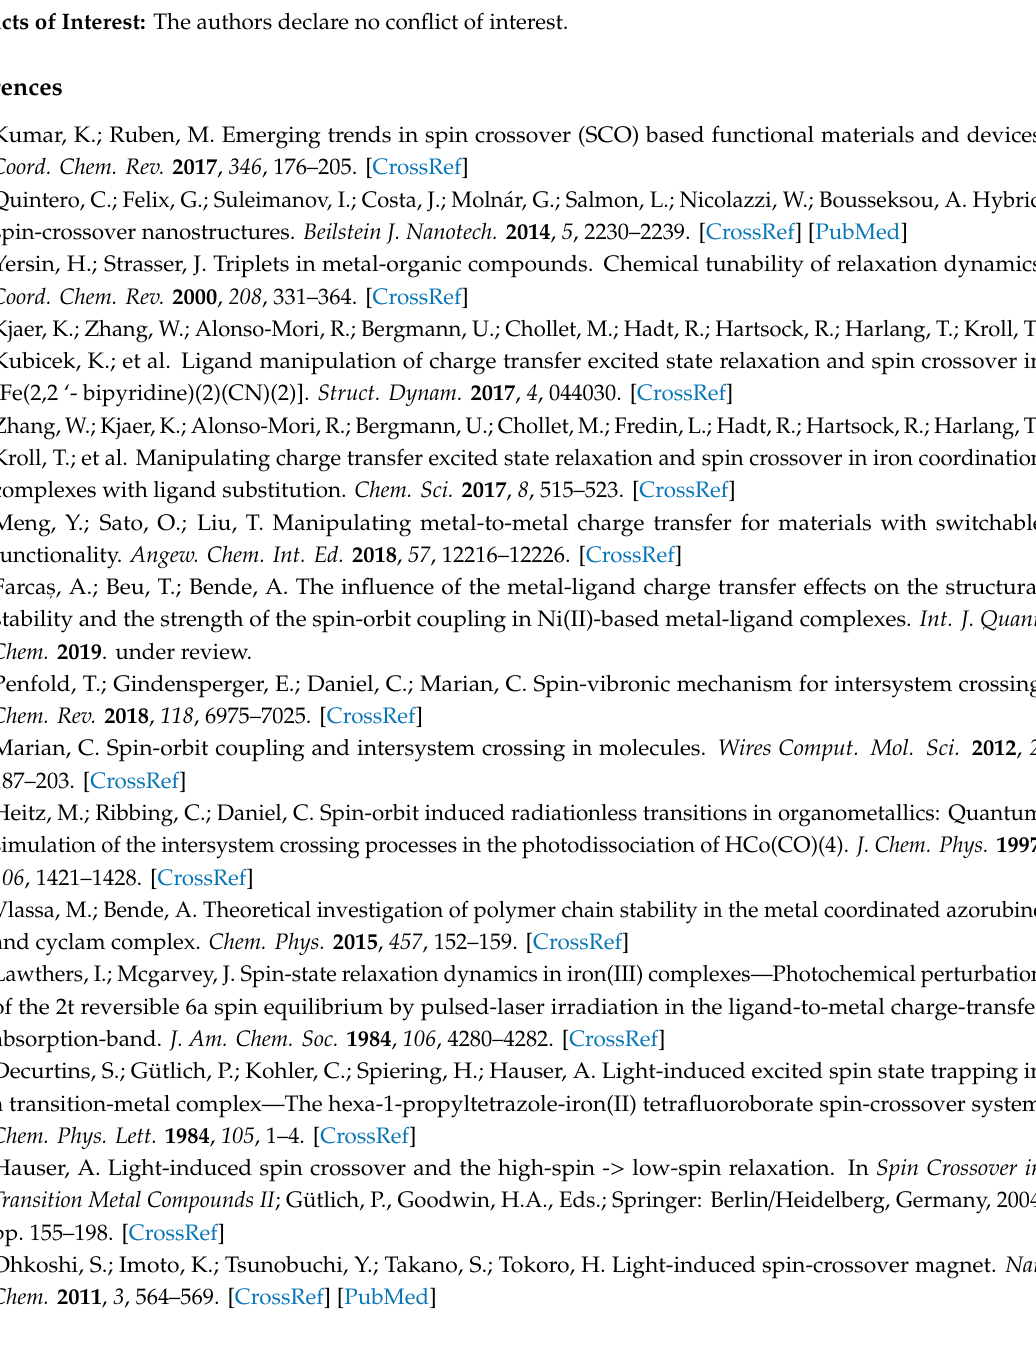
The fractional electron population of di ff erent fragments (Ni(II), PL—planar ligand, VL—vertical ligand), the natural electron population of the central Ni cation, as well as the natural electron population of the 3d orbitals of the central Ni cation for the C4–C6 metal-organic complexes, obtained at NBO / M06 / def2-TZVP level of theory, Table S4: The orbital shapes of the Natural Di ff erence Orbitals (NDO) obtained as the di ff erence between the corresponding ground state and the electronic excited state densities for the five (C1, C2, C4–C6) metal-organic complexes with octahedral coordination computed at TD-DFT / M06 / Def2-TZVP level of theory (blue is the positive, and orange means the negative